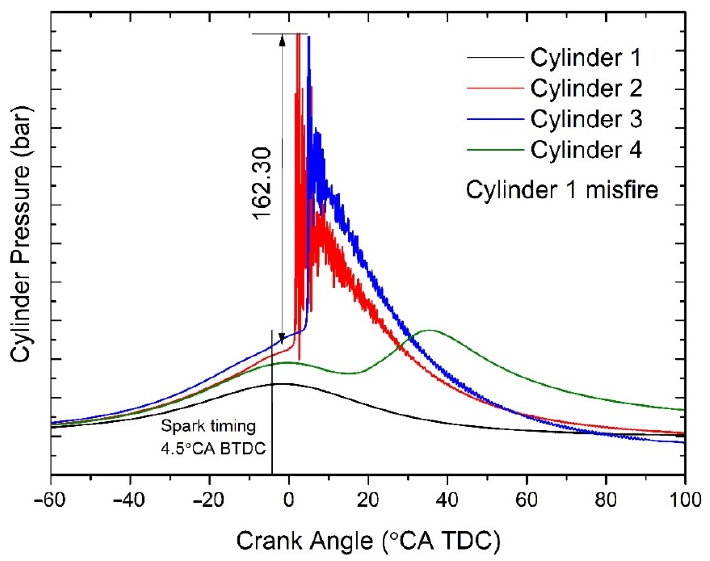
Figure 11. Super ‐ knock in the next and last ignition cylinder corresponding to the misfired cylin ‐ Figure 11. Super-knock in the next and last ignition cylinder corresponding to the misfired der.